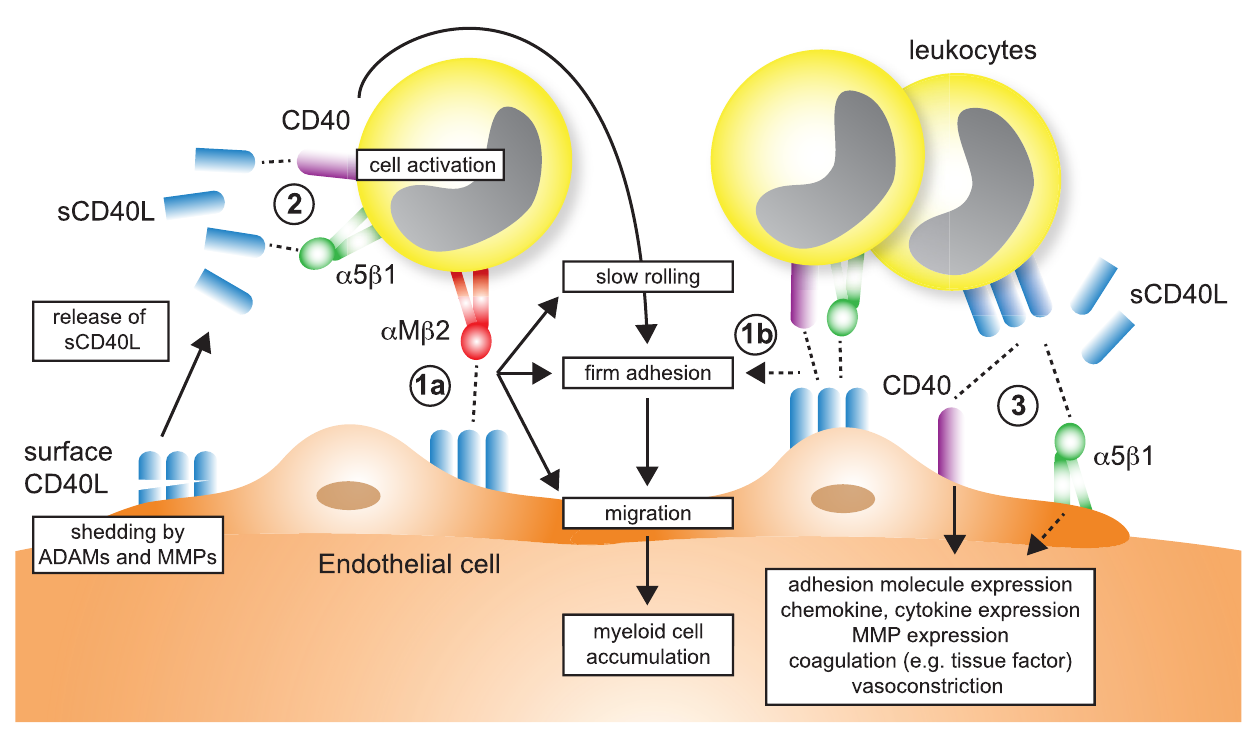
FigURe 5 | Participation of CD40L pathways in leukocyte recruitment. Several simultaneous mechanisms that contribute to the recruitment and transmigration of inflammatory leukocytes in inflamed tissue have been identified: (1a) endothelial cells (ECs) express membrane-bound CD40L in inflammation. The exact dynamics and stability of endothelial-expressed CD40L is unknown, but shedding by ADAMs and matrix metalloproteinases (MMPs) has been described. The interaction of α M β 2 (Mac-1) with endothelial CD40L mediates slow rolling and firm adhesion, which ultimately favors myeloid cell accumulation in tissues. (1b) It has been proposed that besides α M β 2, also CD40 and α 5 β 1, expressed on leukocytes may participate in rolling and adhesion. (2) Ligation of α 5 β 1 and CD40 on leukocytes, either by sCD40L or membrane-bound CD40L from leukocytes, platelets, or ECs activate pro-inflammatory signaling in leukocytes and increased expression of adhesion receptors that will in turn enhance cell recruitment. (3) α 5 β 1 and CD40 expressed on ECs is ligated by sCD40L or cell-bound CD40L. As a result, ECs upregulate adhesion molecule expression and secretion of chemokines, besides other pro-inflammatory